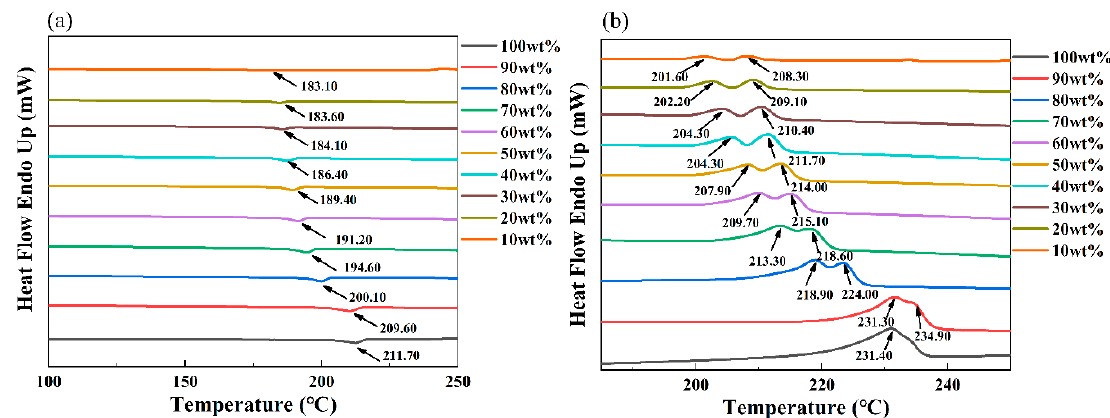
Figure 4. The DSC curves of the PMP-MA system with different PMP concentrations: ( a ) and ( b ) represent the crystallization curves obtained during the cooling period and the melting curves obtained during the heating period, respectively.